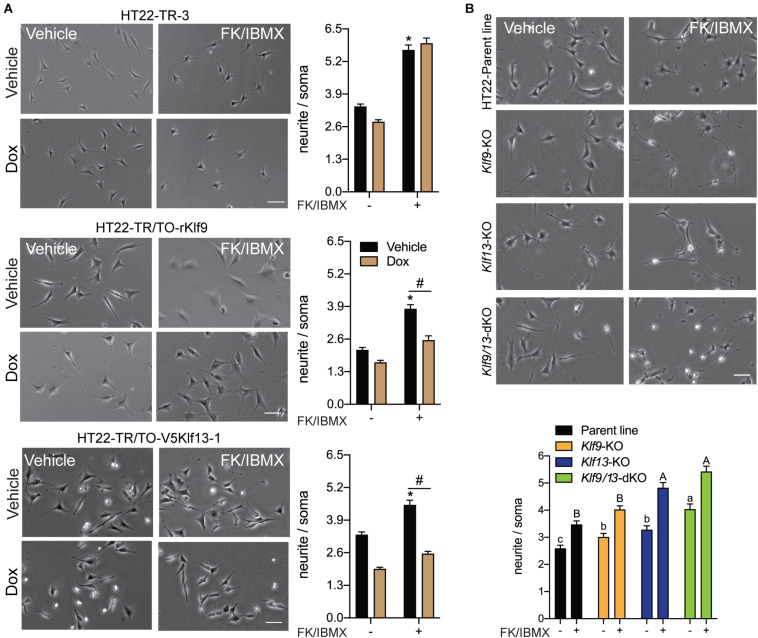
Forced expression of Klf9 or V5Klf13 block, while their deficiency enhances cAMP-dependent neurite-outgrowth in HT22 cells. We analyzed the effects of forced expression of Klf9 or V5Klf13 on cAMP-dependent neurite-outgrowth, or the effects of inactivation of the Klf9 or Klf13 genes using CRISPR/Cas9 genome editing on neurite outgrowth in HT22 cells. We estimated the length of neurites by calculating the ratio of the length of the longest neurite to the width of the soma of each cell analyzed. Bars represent the mean ± SEM (we analyzed > 100 cells/treatment from three independent experiments). (A) We treated HT22-TR-3 (control), TR/TO-Klf9 and TR/TO-V5Klf13-1 cells with vehicle or doxycycline (dox; 1 μg/ml) for 4 h, then added forskolin (FK; 25 μM) plus IBMX (250 μM) for 16 h before fixing cells for morphometric analysis. Shown are representative micrographs with graphs depicting quantification of neurites to the right. Treatment with FK + IBMX induced neurite outgrowth in each of the three cell lines; asterisks indicate statistically significant differences (p < 0.0001; Student’s independent t-test) between cells receiving vehicle (no dox) treated ± FK + IBMX. Treatment with dox had no effect on the response to FK + IBMX in HT22-TR-3 cells, but dox treatment completely blocked the response in HT22-TR/TO-Klf9 and HT22-TR/TO-V5Klf13-1 cells. Hashtags indicate statistically significant differences (p < 0.05; Student’s independent t-test) between vehicle and dox-treated cells that received FK + IBMX. (B) We treated HT22 Klf9-knockout (KO), Klf13-KO and Klf9/13-double-KO cells with vehicle or FK (25 μM) + IBMX (250 μM) for 16 h before fixing cells for morphometric analysis. Shown are representative micrographs with a graph depicting quantification of neurites at the bottom. Inactivation of Klf9, Klf13 or both genes increased the baseline neurite length compared with the HT22 parent cell line [F(3,514) = 15.63, p < 0.0001; one-way ANOVA followed by Tukey’s post hoc test]. Treatment with FK + IBMX increased neurite length in all four cell lines (p < 0.05, Student’s independent t-test), but neurite length was greater in the Klf13-KO and Klf9/13-double KO cells compared with the Klf9-KO and parental cell lines [F(3,589) = 24.13, p < 0.0001]. Means with the same letter are not significantly different (lowercase letters for vehicle treatment, uppercase letters for FK + IBMX treatment).